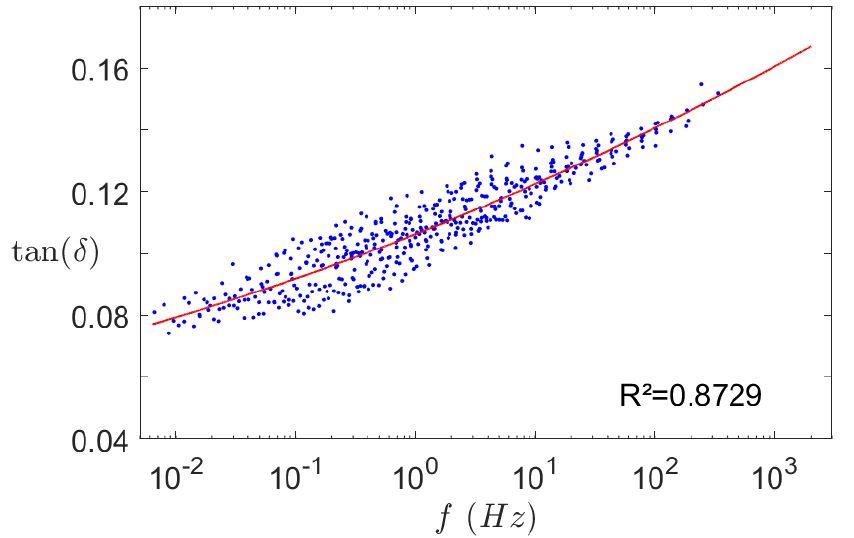
Figure 7. Damping coefficient master curve of the silicone at 22 °C. • Experimental data and quadratic interpolation